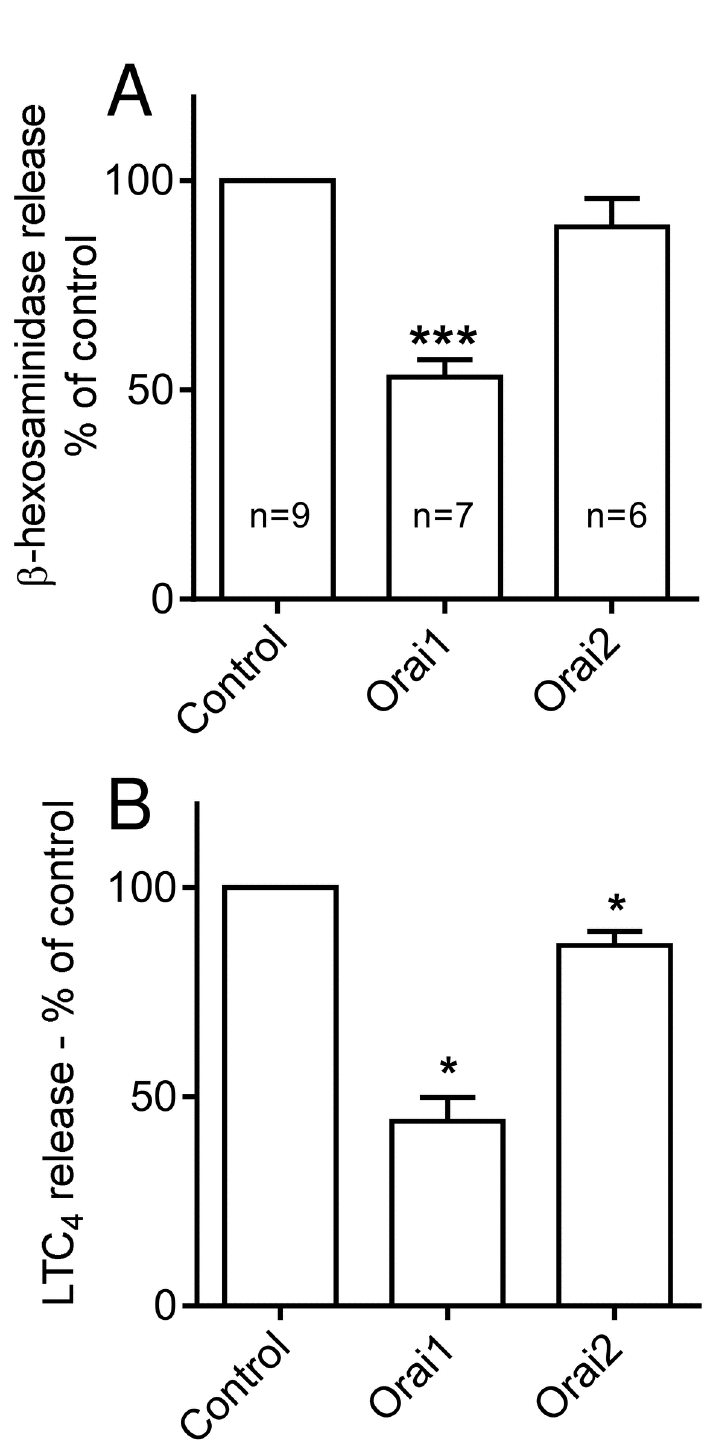
Figure 3. The effect of Orai channel knockdown on the release of HLMC (A) β-hexosaminidase (degranulation) and (B) LTC . The graphs demonstrate the mean ± SEM release presented as a percentage of that observed in control cells transduced 4 with adenovirus expressing shRNA directed against luciferase. n=6-10 independent donors for β-hexosaminidase, n=5 for LTC p<0.05, *** p<0.001.